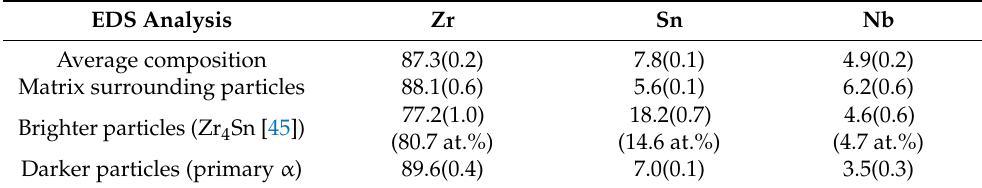
Table 3. EDS analysis of composition of particles found in beta-annealed Zr-8Sn-4Nb.